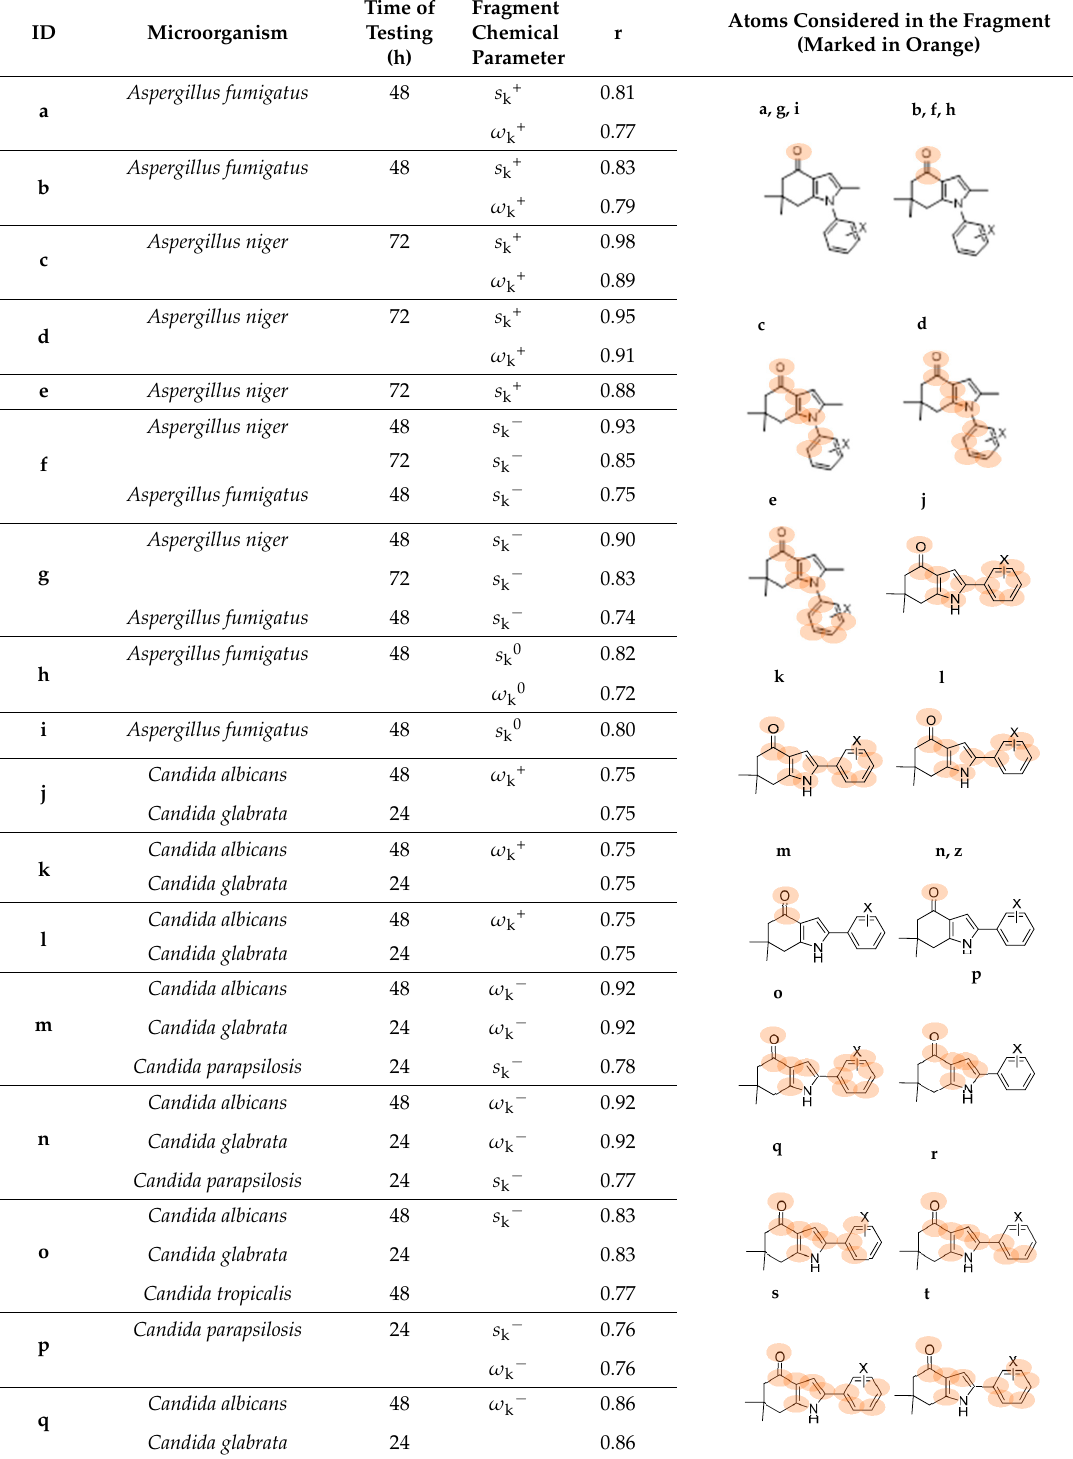
Table 6. Chemical reactivity criterions by fragment for series I (fragment ID: a–i) and series II (fragment ID: j–z).